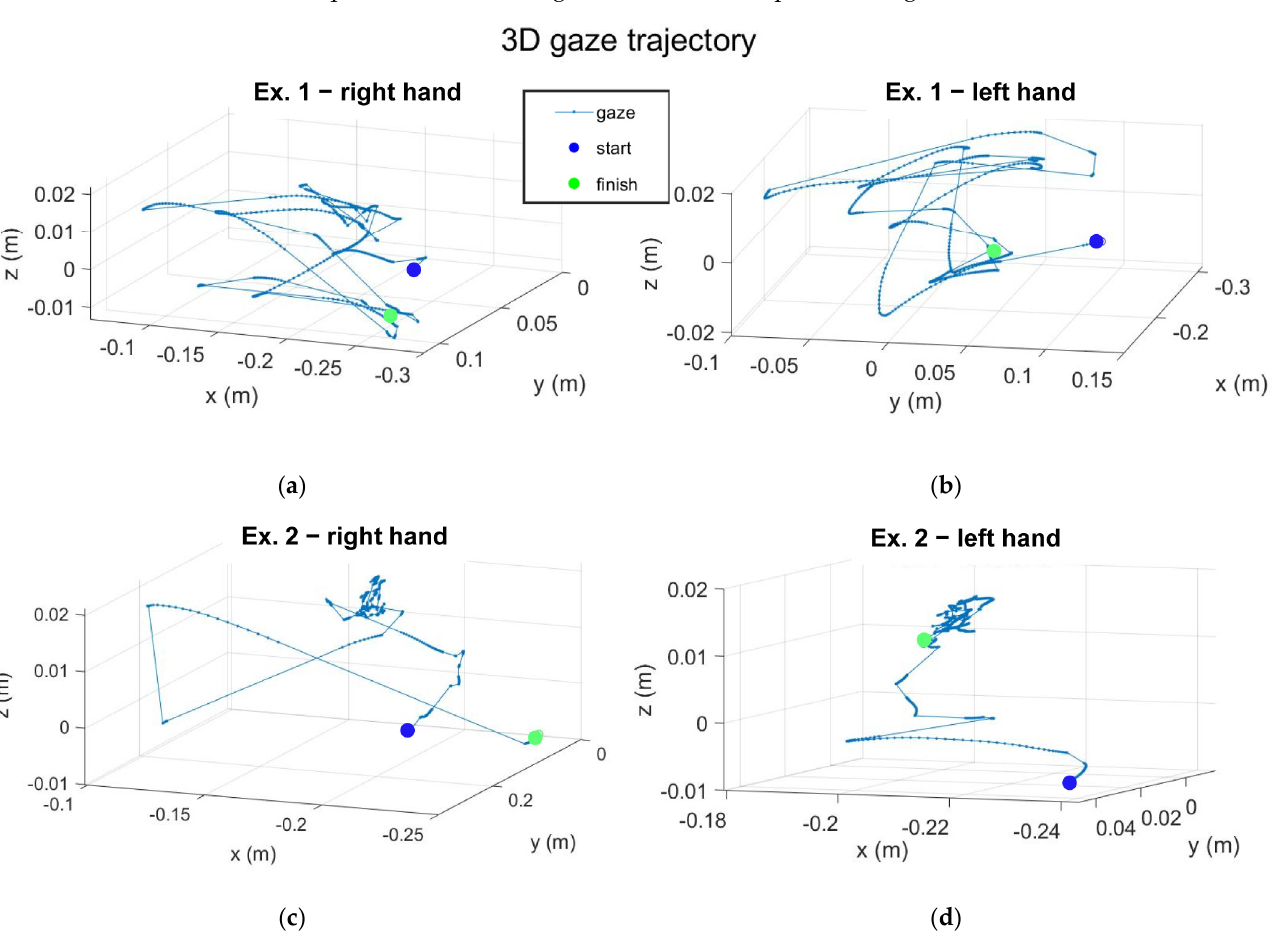
Figure 5. Graphs of the trajectories of the subject’s head: ( a ) trajectory during exergaming 1 per- formed with the right hand, ( b ) trajectory during exergaming 1 performed with the left hand, ( c ) trajectory during exergaming 2 performed with the right hand, ( d ) trajectory during exergaming 2 performed with the left hand.